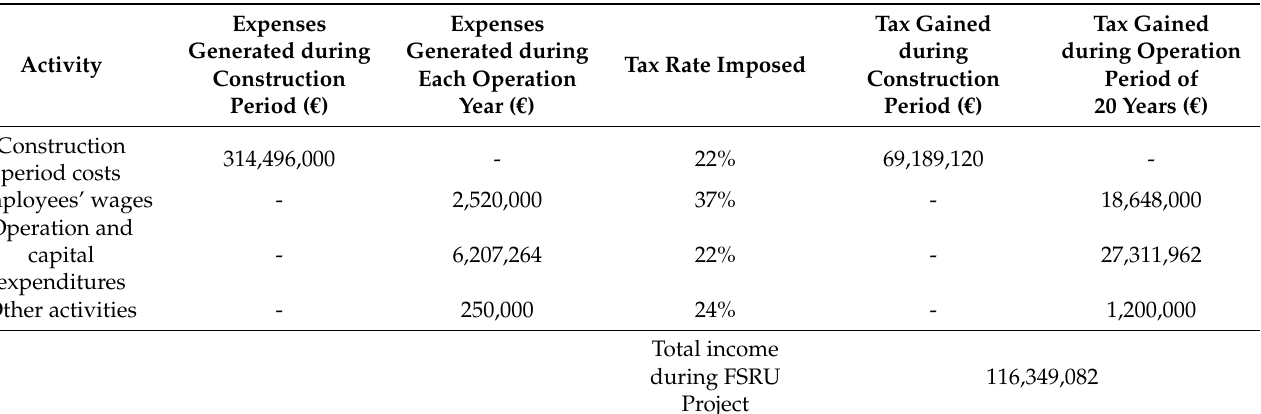
Table 5. Taxes generated by FSRU Project over